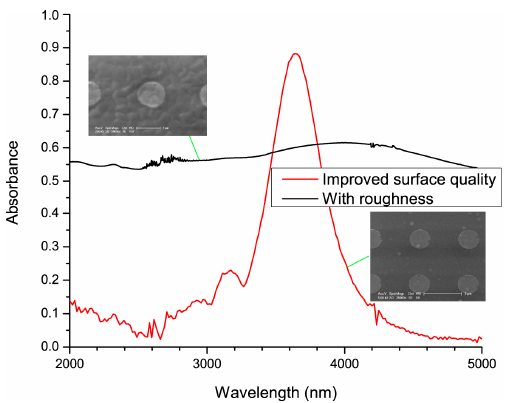
Figure 3. Absorption spectra of circular disk metamaterial (diameter = 1100 nm, period = 2600 nm) with and without roughness. The SEM graph of the surface is shown in the insert.